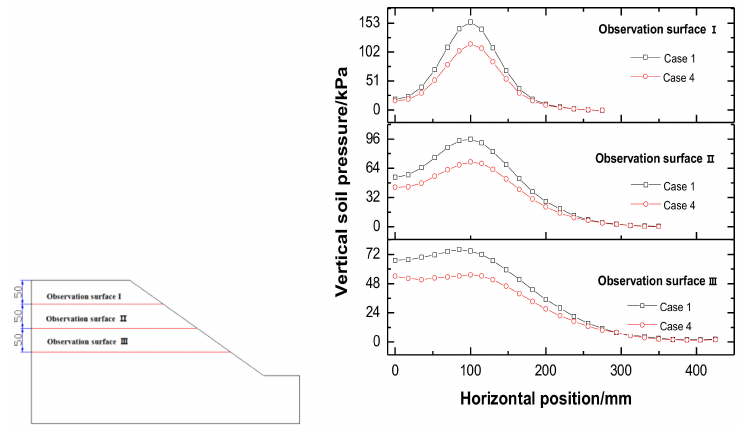
Figure 9. Vertical soil pressure of embankment under different conditions.